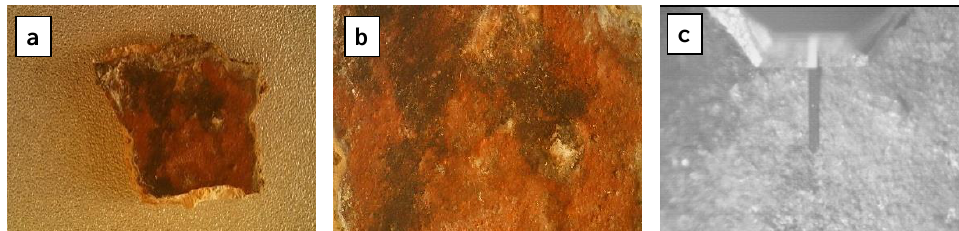
Figure 5. The composite material of the fresco with red paint applied on the outside in ( a , b ) and the area analyzed by atomic force microscopy in ( c ).